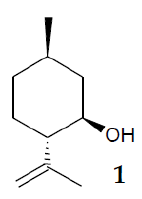
Figure 1. Structure 1: (‒) -isopulegol.